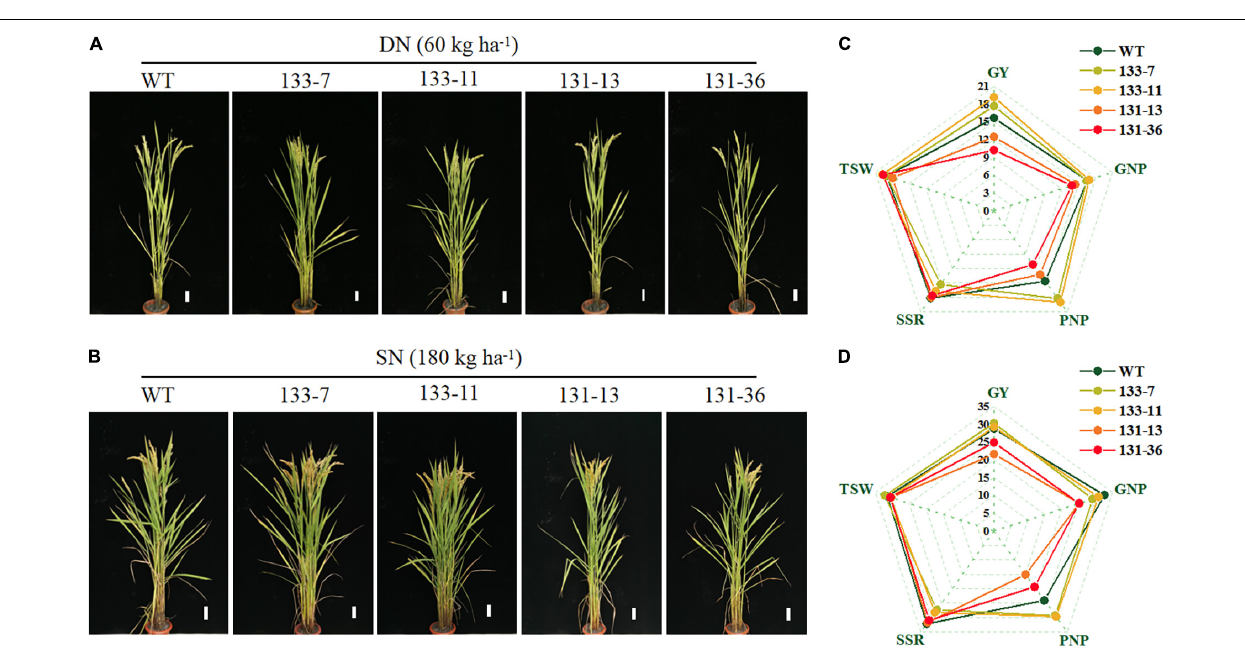
FIGURE 4 | Effects of OsNAC68 on phenotypes and grain yield of rice under different nitrogen fertilizer levels. (A,B) Phenotypes of the whole rice plants WT and transgenic lines under DN and SN conditions at the ripening stage. Scale bar, 5 cm. (C,D) Grain yield of the WT and transgenic lines under DN and SN conditions. GY, grain yield; GNP, grain number per panicle; PNP, panicle number per plant; SSR, seed setting rate; TSW, 1,000 grain